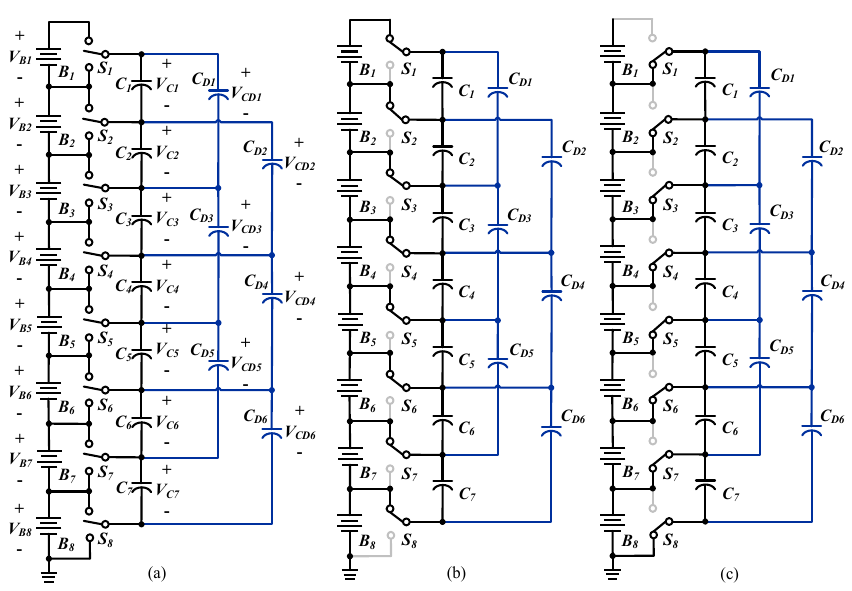
Figure 2. Double-tiered SC-based BE*: ( a ) circuit architecture; ( b ) first state; ( c ) second state. * Eight batteries are shown as examples. The configuration of the modularized SC-based BE (type C) is illustrated in Figure 3. The battery string is divided into multiple modules, including the inter-module and intra- module equalizers. Both of the equalizers use the switched-capacitor system. The energy transfer can be applied not only on a cell-to-cell basis, but also on a module-to-module basis in the equalizer [19].